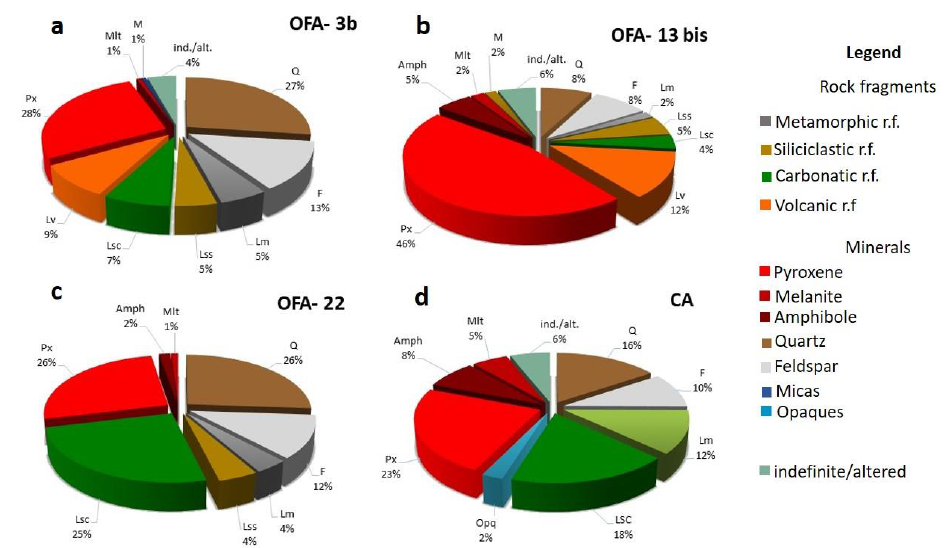
Figure 4. Microphotos of diagnostic grains in the studied samples. All the images are in plane-po- larized light. ( a ): sample OFA-3b, general view of the sand. Garnet (dark brown), light and dark- green pyroxene, quartz, feldspar and volcaniclastic rock fragments are visible. ( b ): sample OFA-3b, zoned, dark-green clinopyroxene (cpx), surrounded by quartz (qz) and feldspar (feld) crystals. A light-green pyroxene is also visible on the left; ( c ): sample OFA-13bis. Dark-green pyroxene sur- rounded by dark volcanic glass and light green pyroxene. An opaque (opq) is also visible on the right; ( d ): sample OFA-13bis, sub-rounded melanite (mln) crystal; ( e ): sample OFA-22, rounded quartz crystals and carbonatic sedimentary rock fragments (Lsc); ( f ): sample OFA-22, amphibole (amph), melanite and pyroxene crystals; ( g ): sample CA, general view of the sand. Light and dark green pyroxene, melanite, quartz and feldspar crystals and well-rounded carbonatic rock fragments are visible; ( h ): sample CA, melanite, pyroxene and feldspar crystals. Abbreviations as in Figure 5.